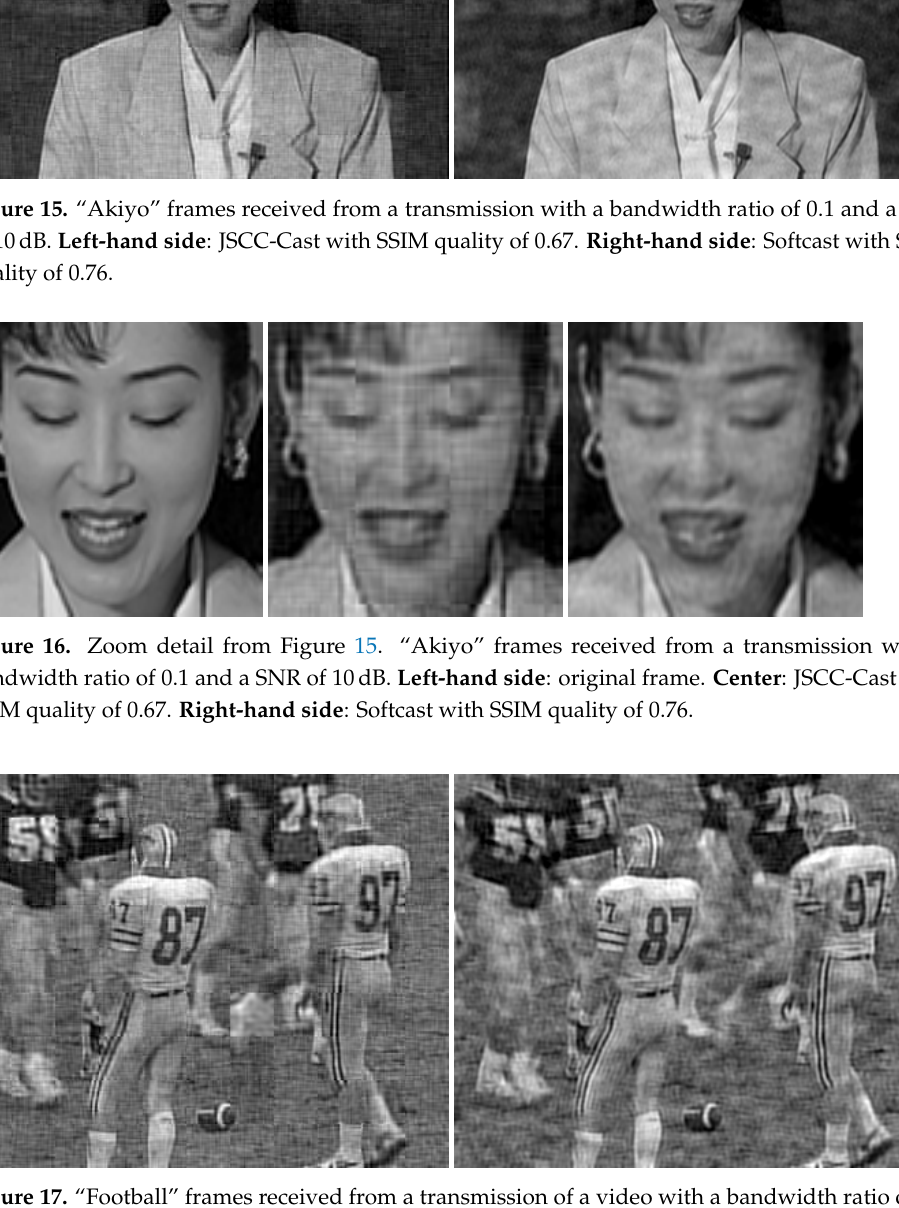
Figure 17. “Football” frames received from a transmission of a video with a bandwidth ratio of 0.1 and SNR = 10dB. Left-hand side : JSCC-Cast with SSIM quality of 0.66. Right-hand side : Softcast with SSIM quality of